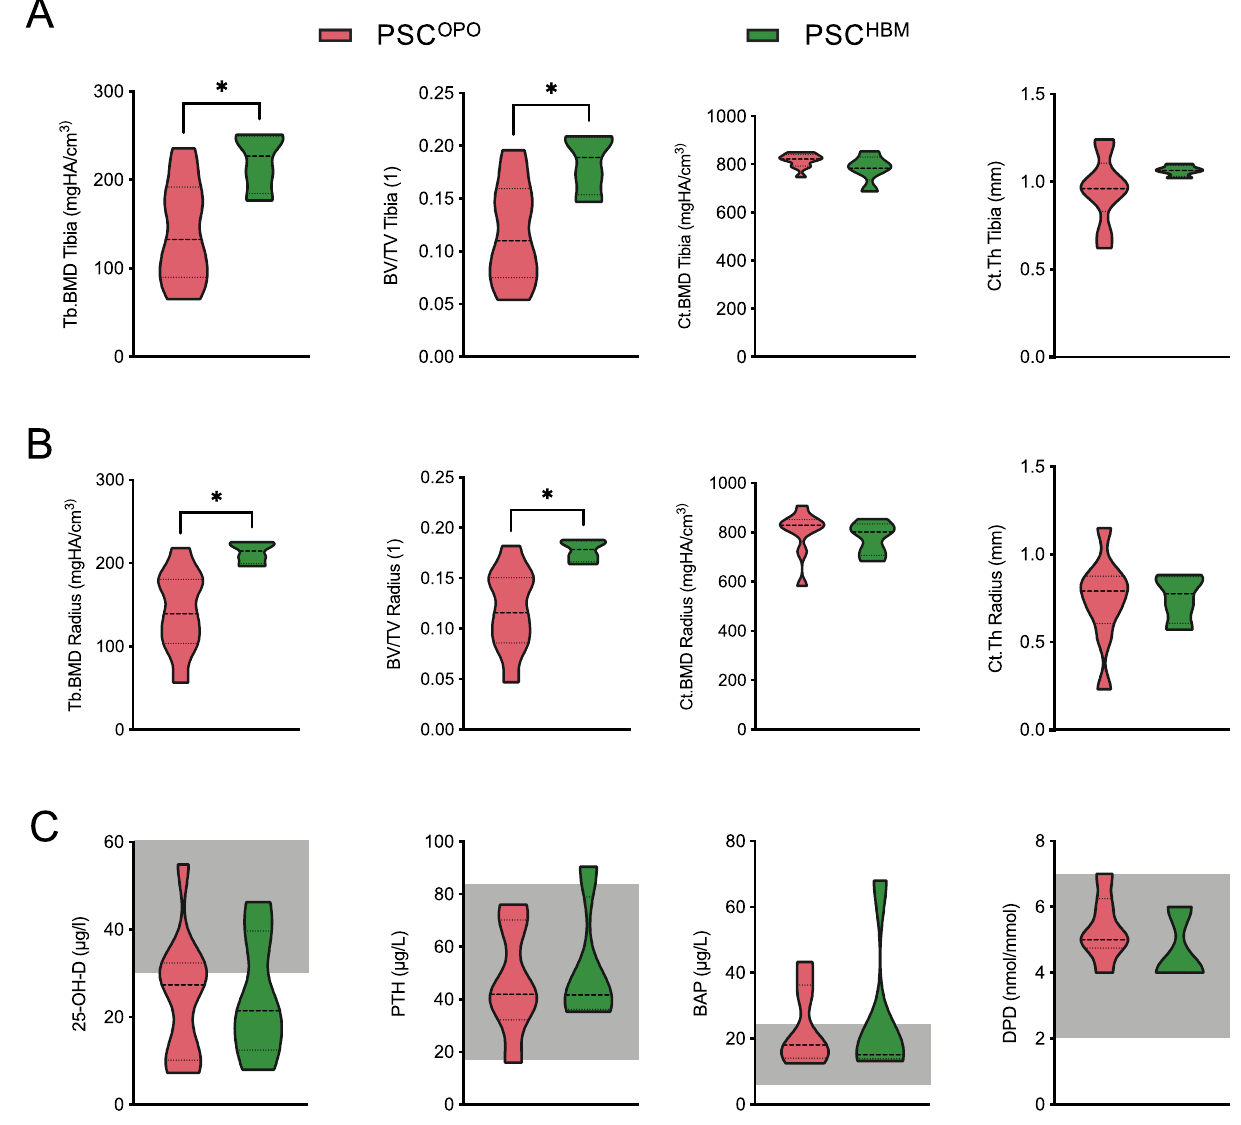
Figure 1. Bone microarchitecture and disease-associated parameters of PSC OPO and PSC HBM patients. ( A,B ) Parameters of the three-dimensional bone microarchitecture were evaluated via HR-pQCT at the distal tibia ( A ) and the distal radius ( B ). Shown is quantification of the trabecular bone mineral density (Tb.BMD), bone volume to tissue volume (BV/TV), cortical bone mineral density (Ct.BMD) and cortical thickness (Ct. Th). ( C ) Biochemical analysis was performed to evaluate relevant markers of calcium homeostasis and bone turnover, i.e., vitamin D (25-OH-D), parathyroid hormone (PTH), bone-specific alkaline phosphatase (BAP), and urinary deoxypyrodinoline (DPD). Data were analyzed by student’s t-test. * p < 0.05, ** p < 0.01, *** p < 0.001, **** p < 0.0001.